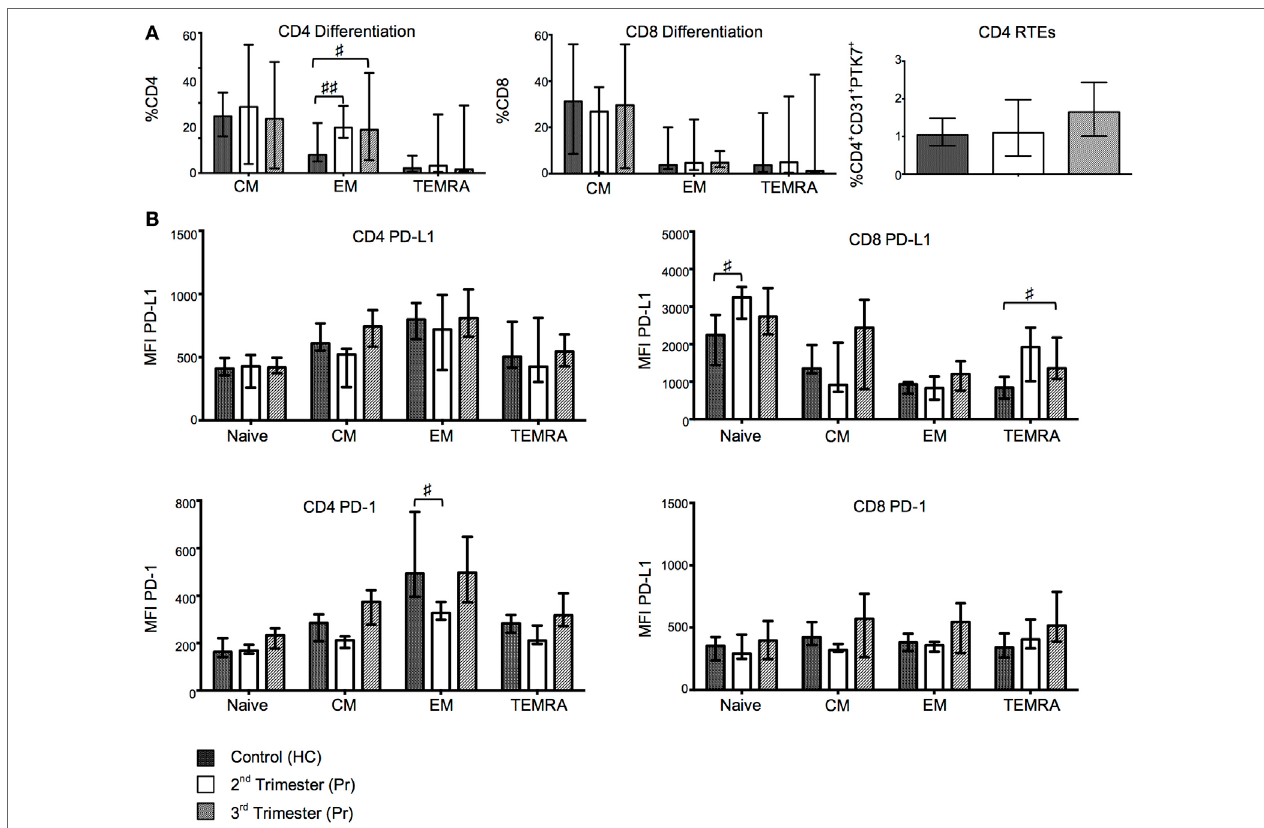
FigUre 2 | Changes in T-cell maturation and exhaustion with normal pregnancy. (a) Shows the frequencies of naïve, EM, CM, and TEMRA CD4 and CD8 T cells as determined by flow cytometry in pregnant (Pr) and health control (HC). Additionally, we show proportions of CD4 recent thymic emigrants determined by CD31 and PTK7 coexpression. (B) Programmed death-1 (PD-1) and PD ligand 1 (PD-L1) expression measured by mean florescence intensity (MFI) on naïve, EM, CM, and TEMRA CD4 and CD8 T cells. Columns indicate median and error bars interquartile range. ♯ p < 0.05 and ♯♯ p < 0.01 (Kruskal–Wallis one way analysis of variance and Dunn’s test for multiple